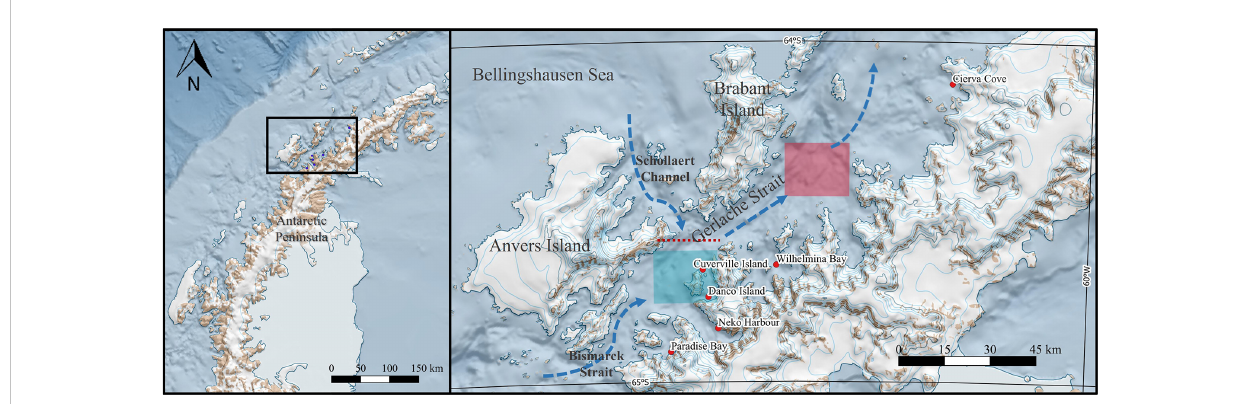
FIGURE 1 Map showing the six sampling sites on the WAP coast between 64° and 65° S. The front is marked with a red dashed line at the location proposed from observations in previous studies (i.e., around 64.5° S, Torres Parra et al., 2020). The areas are clustered to the estimated front location into northern areas (2 sites): Cierva Cove and Wilhelmina Bay; and southern areas (4 sites): Cuverville and Danco Islands, Neko Harbor, and Paradise Bay. The blue arrows show the directions of surface currents. The squares show where satellite data was extracted from the northern region (red) and southern region (light-blue) of the Gerlache